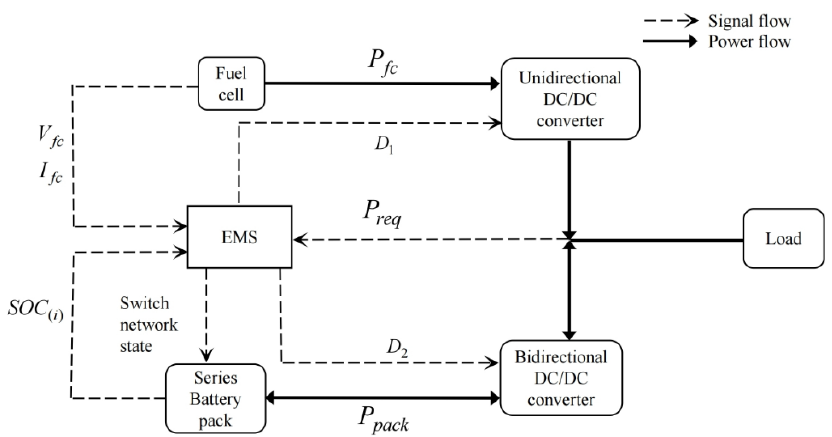
/ lithium battery hybrid